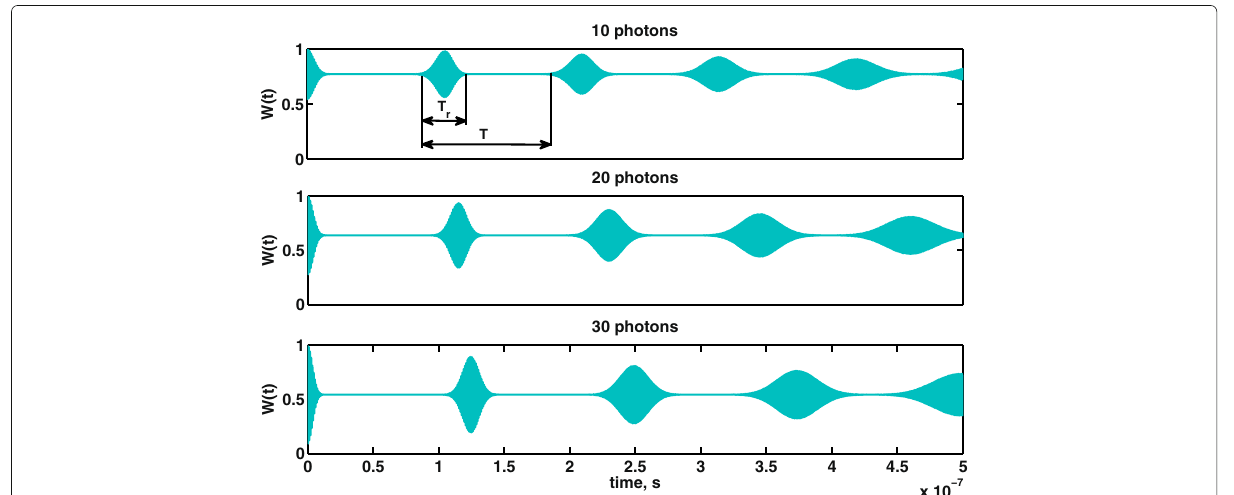
Fig. 5 Revivals and collapses in population inversion in two-level system interacting with quantized EM field. In the calculations, we used the following values of parameters: (cid:7) = ω − (cid:8) = 5 × 10 9 Hz , ω = 5 × 10 12 Hz , g = 4.15 × 10 8